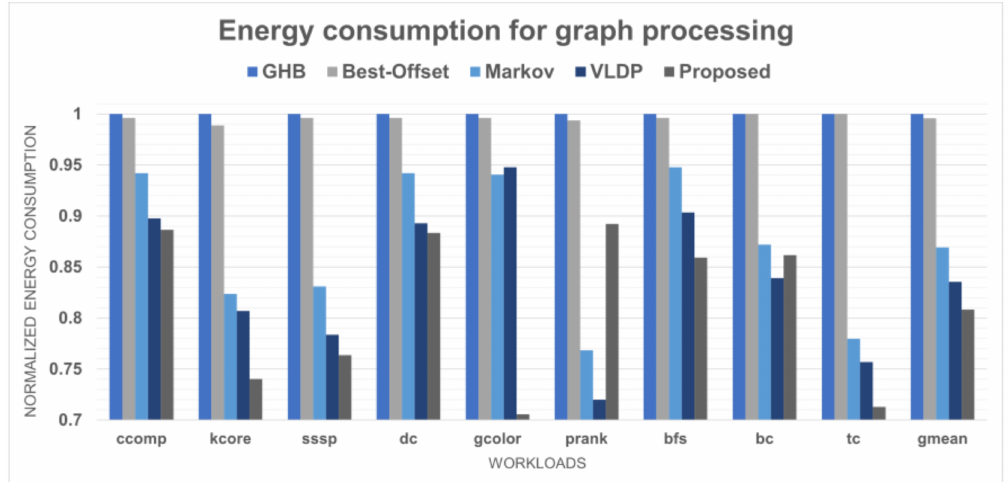
Figure 20. Energy consumption for graph processing